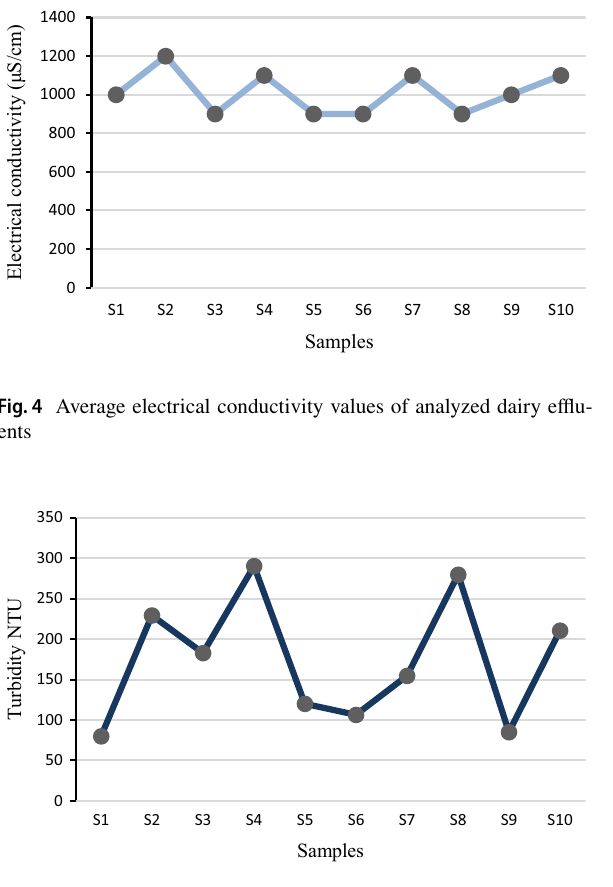
Fig. 5 Turbidity values of analyzed dairy